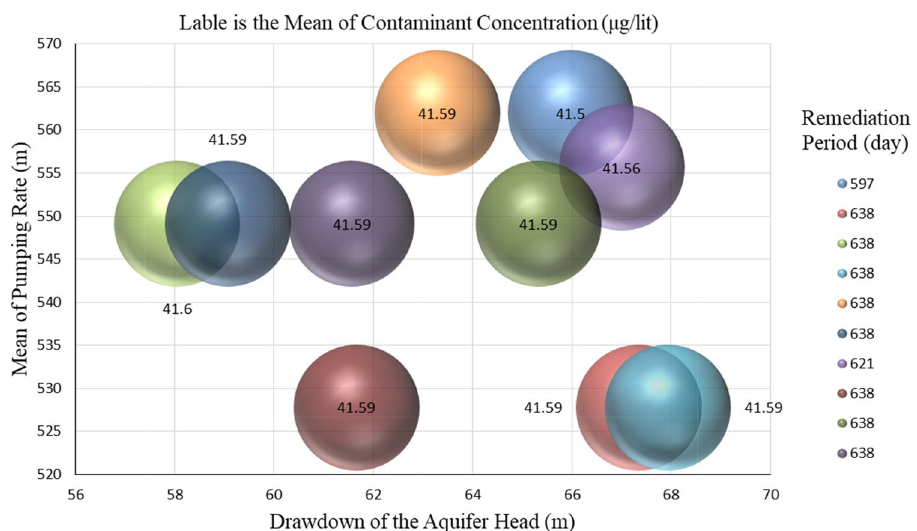
Fig. 11 Pareto front of NSGA-II algorithm in four objective